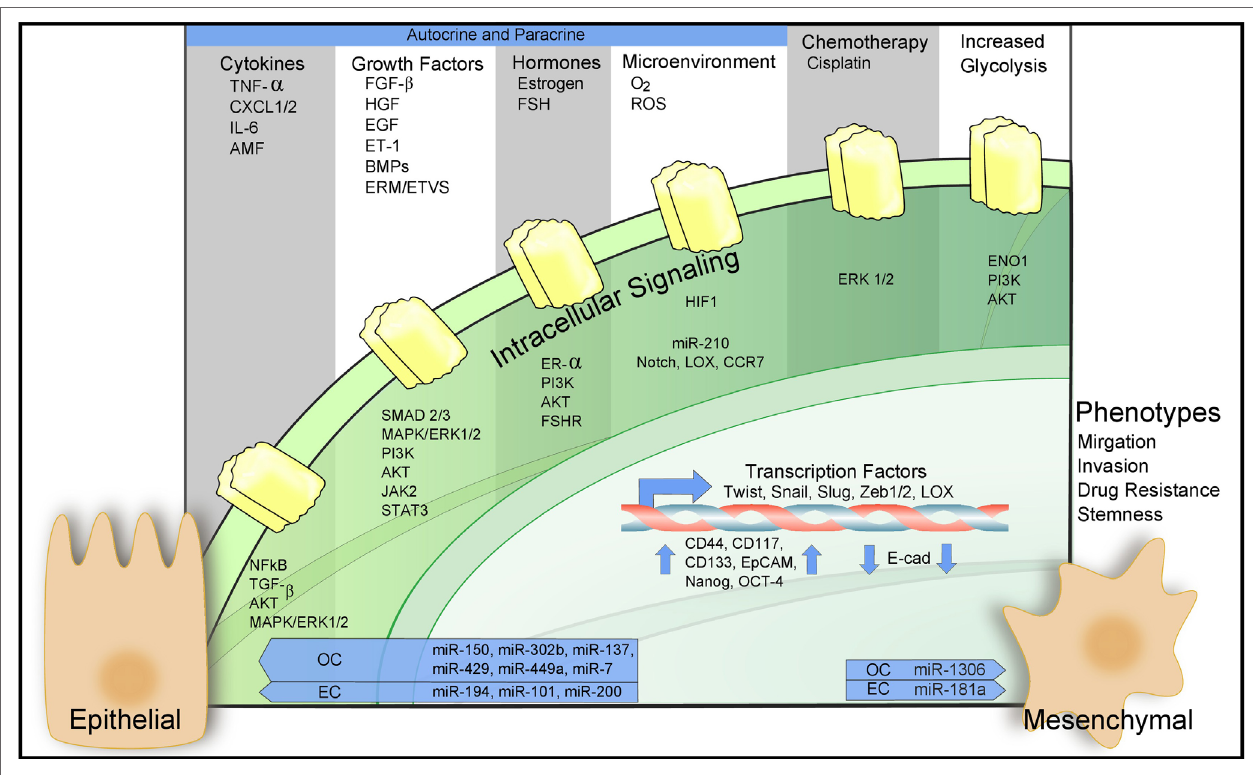
FigURe 2 | Epithelial-to-mesenchymal transition (EMT) in ovarian and endometrial cancers (ECs). Regulation of EMT-inducing signaling pathways through autocrine–paracrine signaling, chemotherapy, increased glycolysis, and the action of microRNAs. For a detailed description of the diagram and references refer to Sections “EMT in the Female Reproductive Tract,” “Molecular Mechanisms Governing EMT in Ovarian and ECs,” and “Microenvironmental Regulation of EMT in Cancers of the Female Reproductive